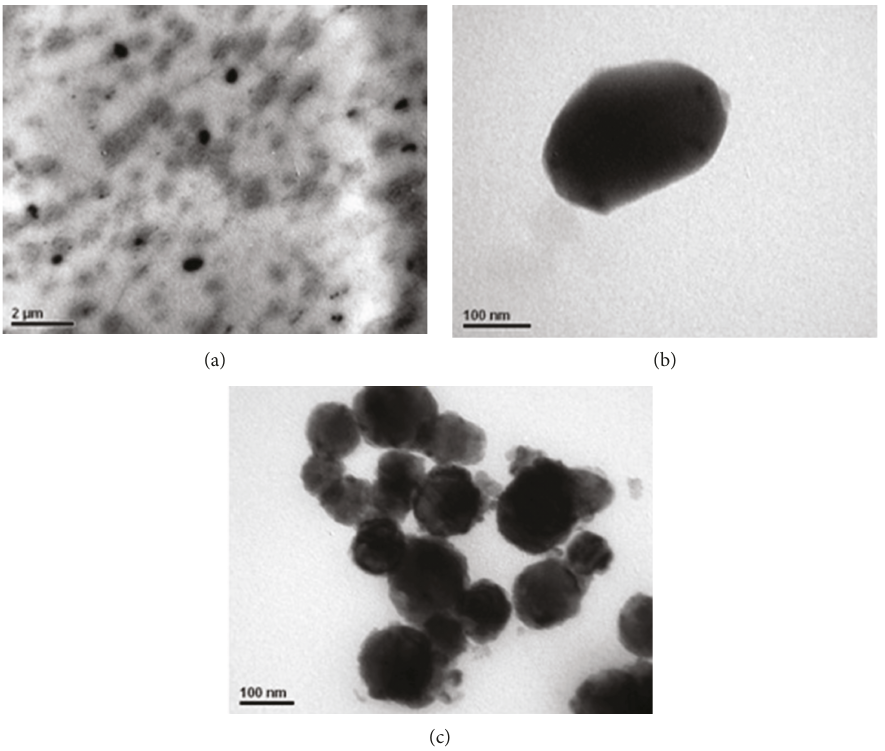
Figure 5: (a) PLA/PHB 75/25, (b) PLA/PHB/AgNPs, and (c)